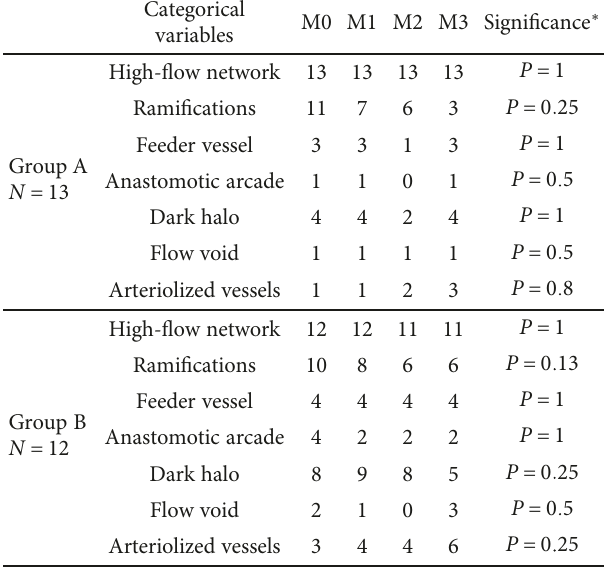
Table 1: Comparison of categorical variables between baseline and month 3 in groups A (treatment-naive patients undergoing monthly loading phase) and B (treated patients undergoing PRN